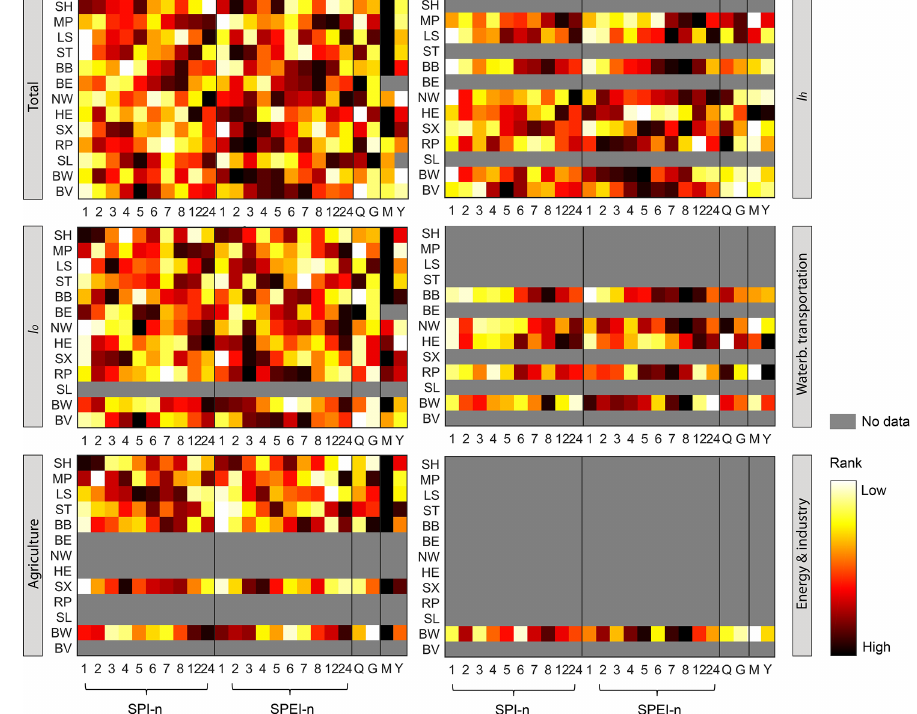
Figure 7. Germany: ranks of predictor importance during random forest construction for total impacts, hydrological drought impacts ( I h ), impacts due to other types of drought ( I o ), and selected impact categories per per NUTS1 region (Waterb. transportation stands for waterborne transportation).